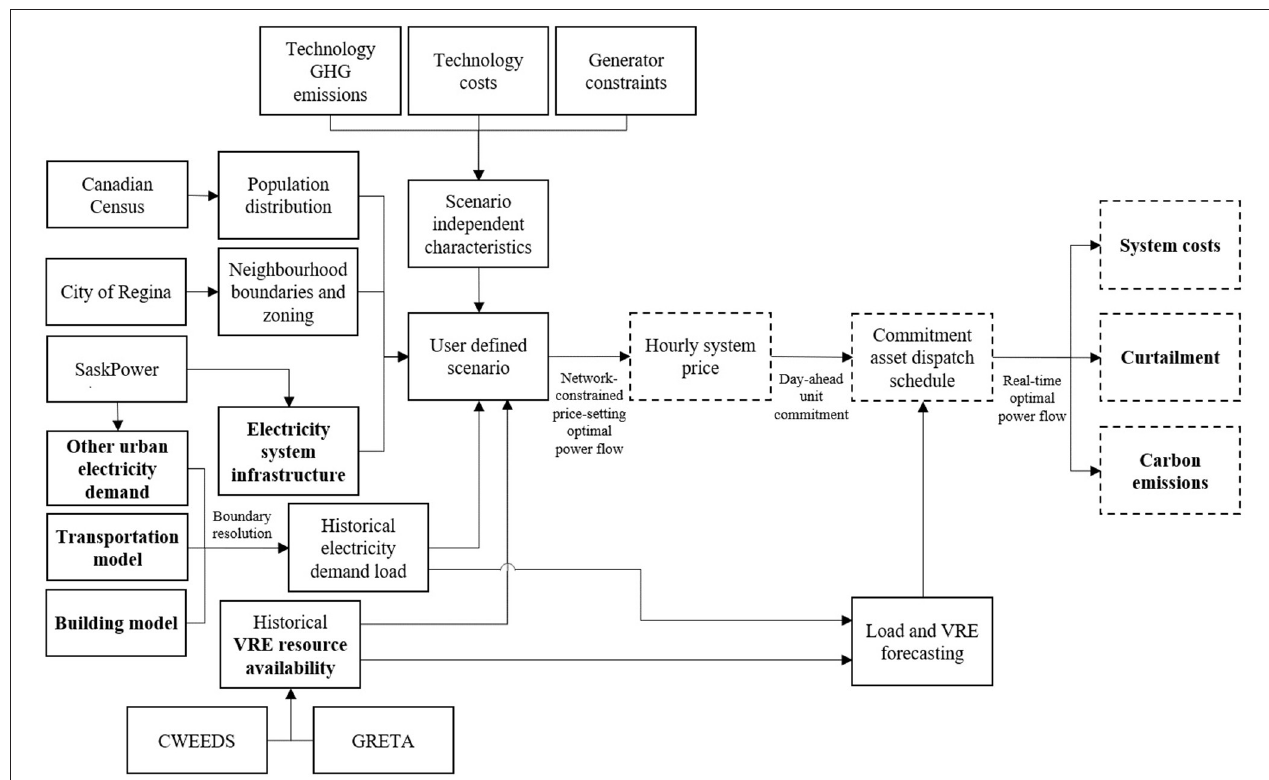
FIGURE 5 | Electricity model processes, with solid boxes representing raw data inputs and dashes boxes representing a processed output. Note that bold text represents a direct tie-in to Figure 2